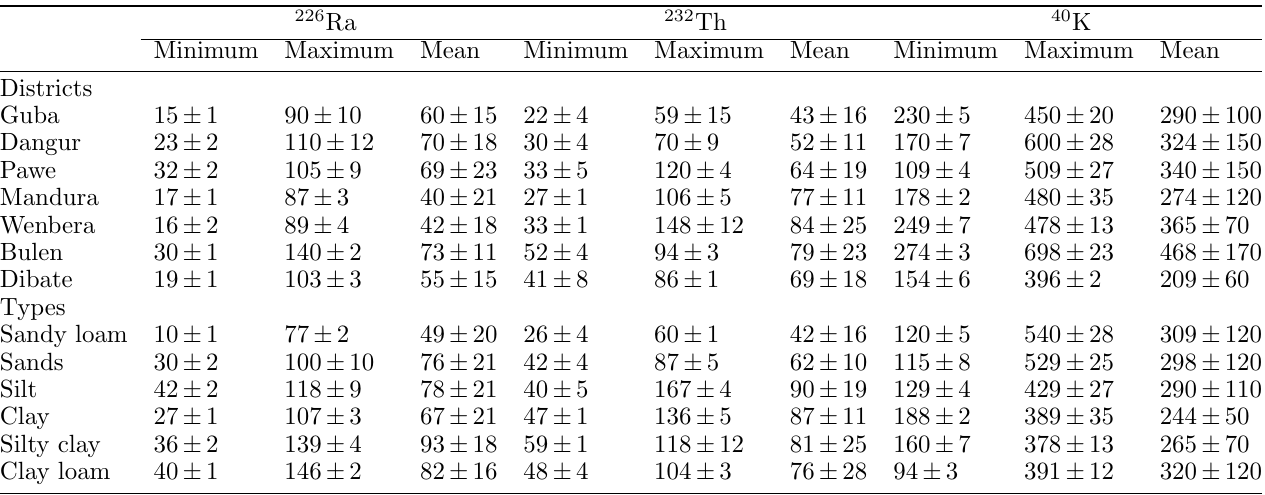
Table 1. The measured concentrations different districts in Metekel and types.